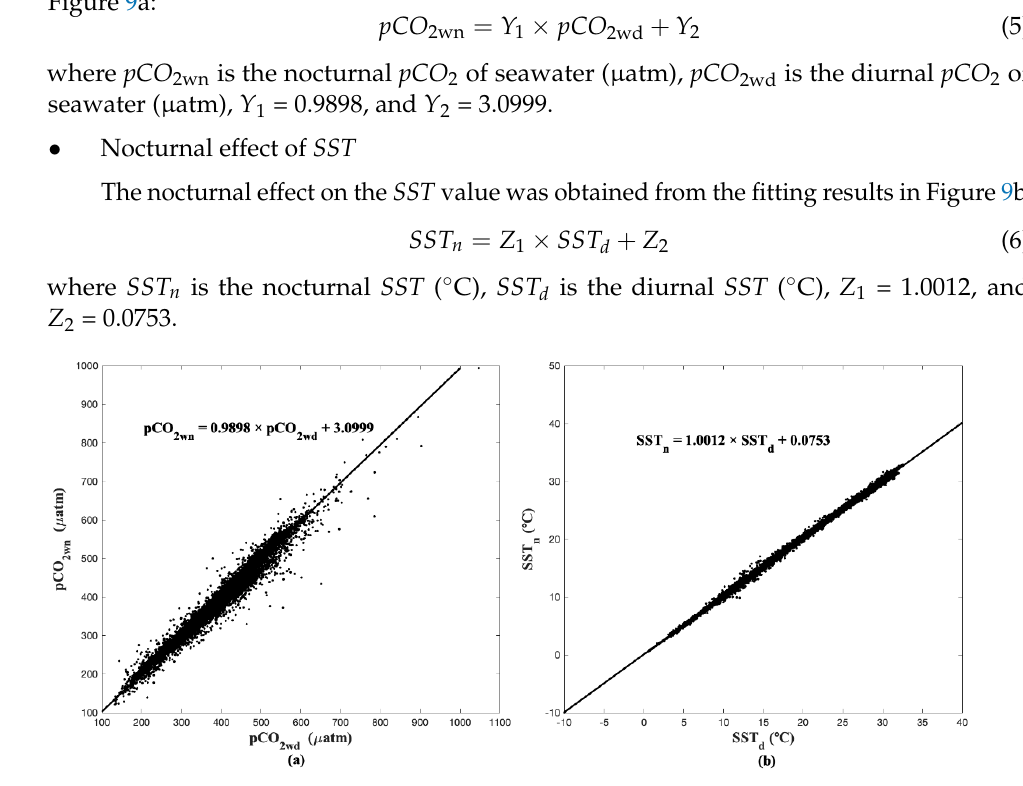
Figure 9. Fitting results of ( a ) nocturnal pCO 2w ( pCO 2wn ) and diurnal pCO 2w ( pCO 2wd ), and ( b ) noc- turnal SST ( SST n ) and diurnal SST ( SST d ), whereby fitting results of using 75% of the data from 2010 to 2020.